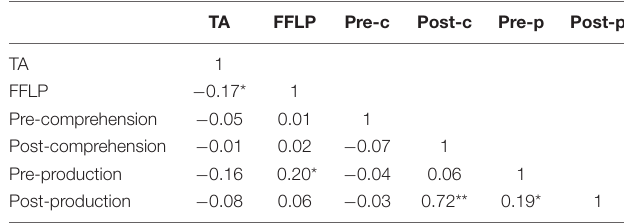
TABLE 4 | The relationships among TA, FLLP, and the pre–post-test TS comprehension and production.